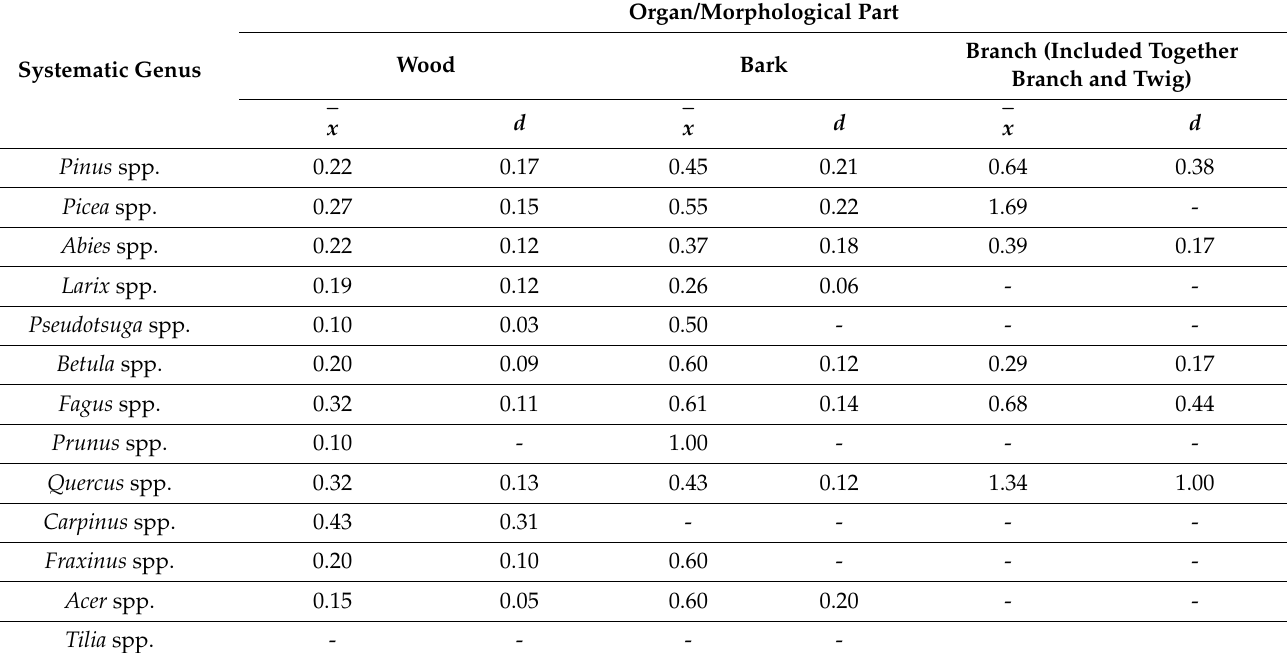
Table A19. Average value and average deviation of the nitrogen content (% d.m.) in various organs of particular systematic genera